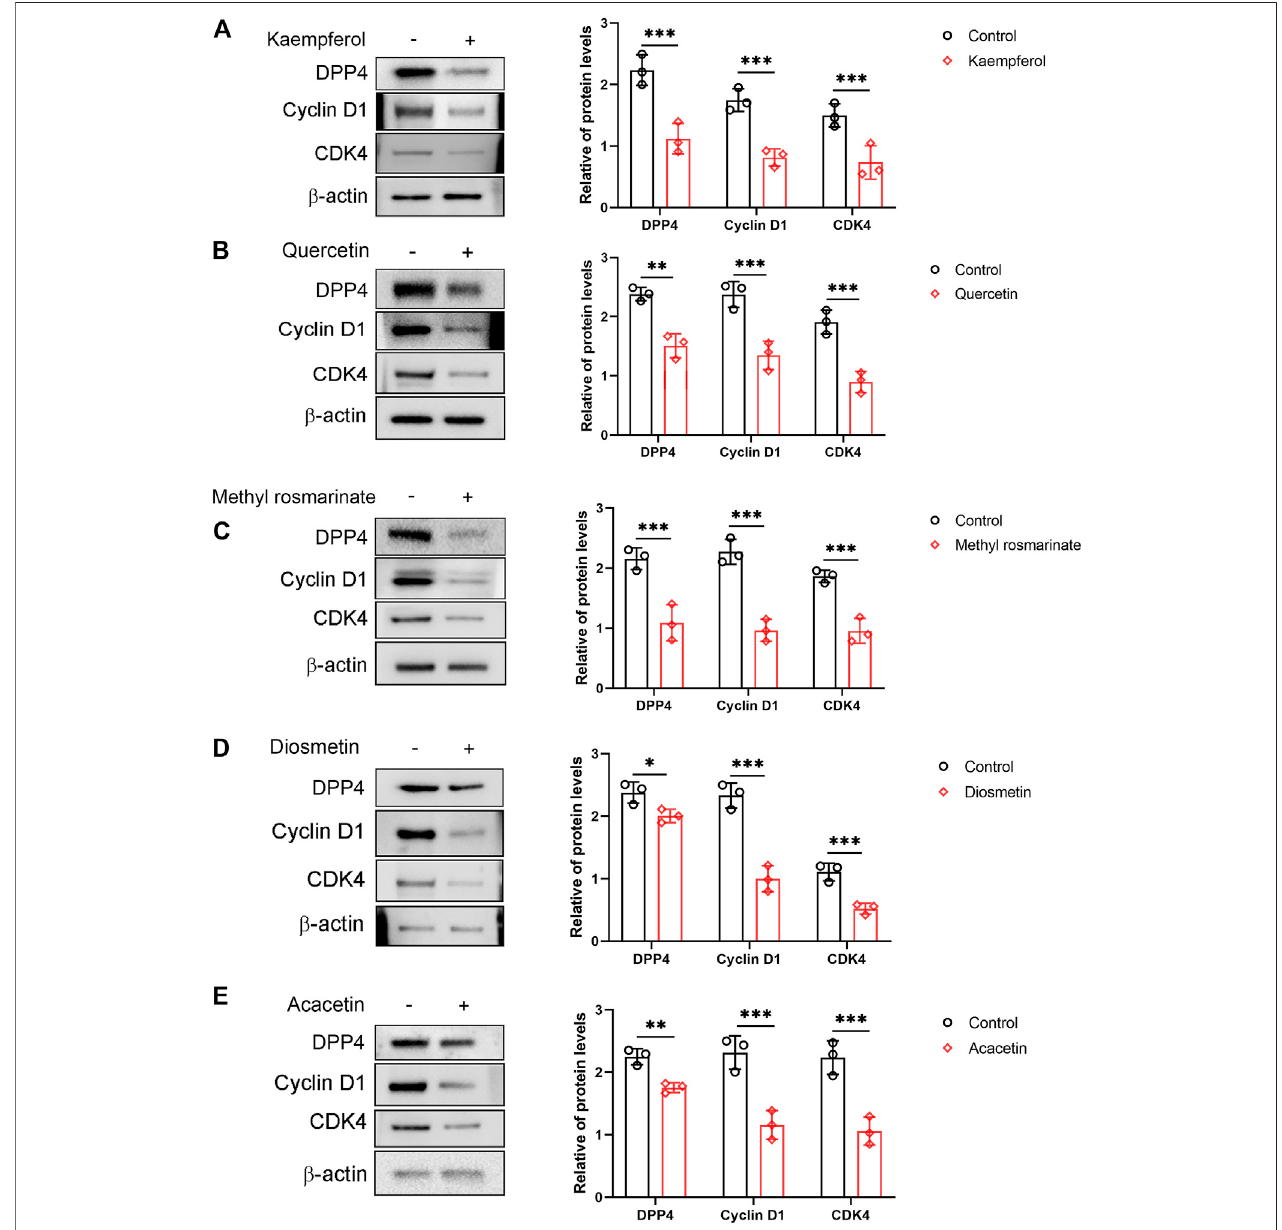
FIGURE 6 | Effects of compounds on the expression of cyclin D1 and CDK4 in immortalized human podocytes. (A – E) Immortalized human podocytes were exposed to either vehicle alone (control) or compounds (10 nM) for 5 days, then the expression of DPP4, cyclin D1 and CDK4 was evaluated by western blot analyses. β -Actin was adopted as an internal standard to control for unwanted sources of variation. n (cid:1) 3. * p < 0.05, ** p < 0.01, *** p < 0.001 vs normal control, by unpaired Student ’ s t -test.